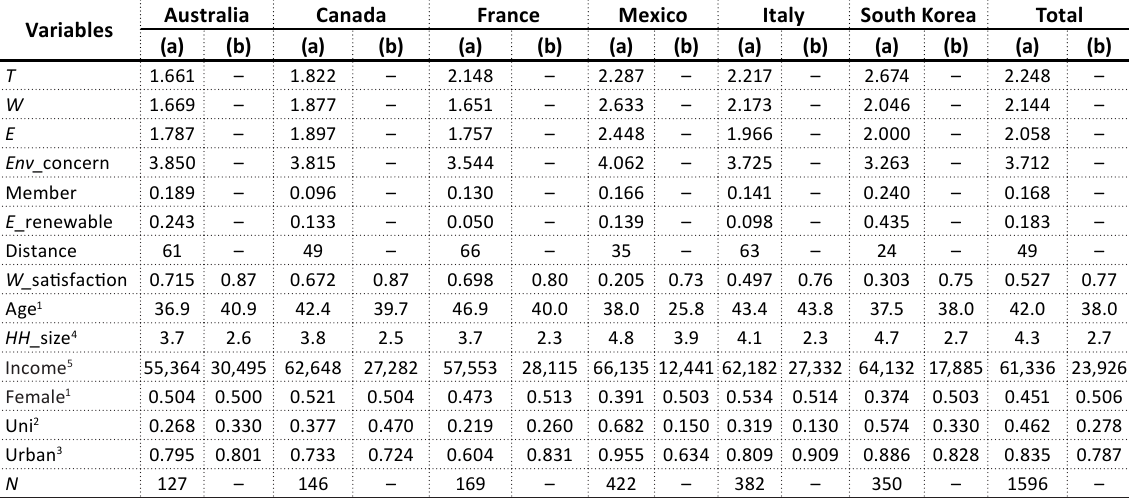
Table 2. Descriptive statistics per country (means)